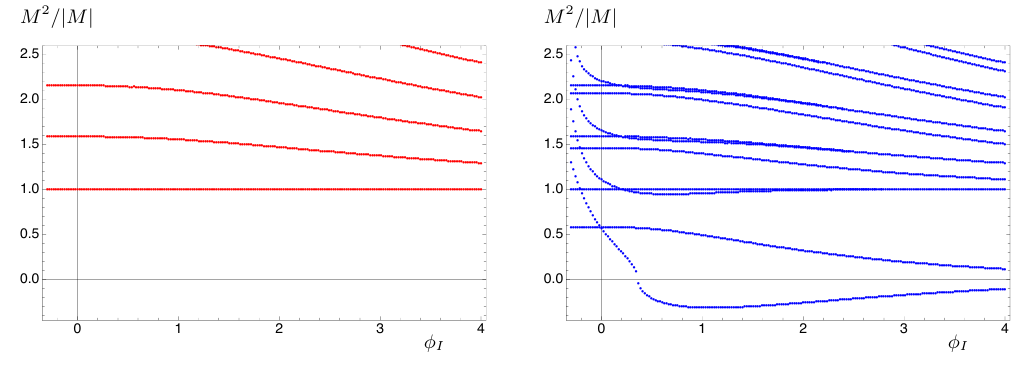
Figure 2 . Mass spectrum M 2 = − q 2 of tensor modes (left panel) and active scalars (right panel) as a function of the parameter φ , normalised in units of the lightest tensor mode. Numerical I calculations use ρ = 10 − 10 and ρ = 10 1 2